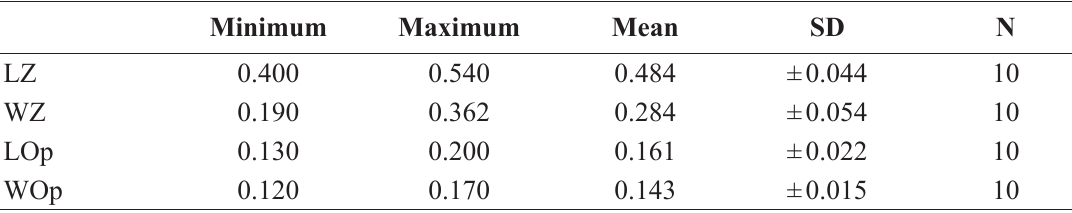
Table 6. Measurements in mm of Crepis gurjarensis Guha & Gopikrishna, 2005 (GIS/B 0504 to 0514), Aquitanian, lower Miocene, Kharinadi Formation, western Kachchh, Gujarat, India. Abbreviations: see Material and